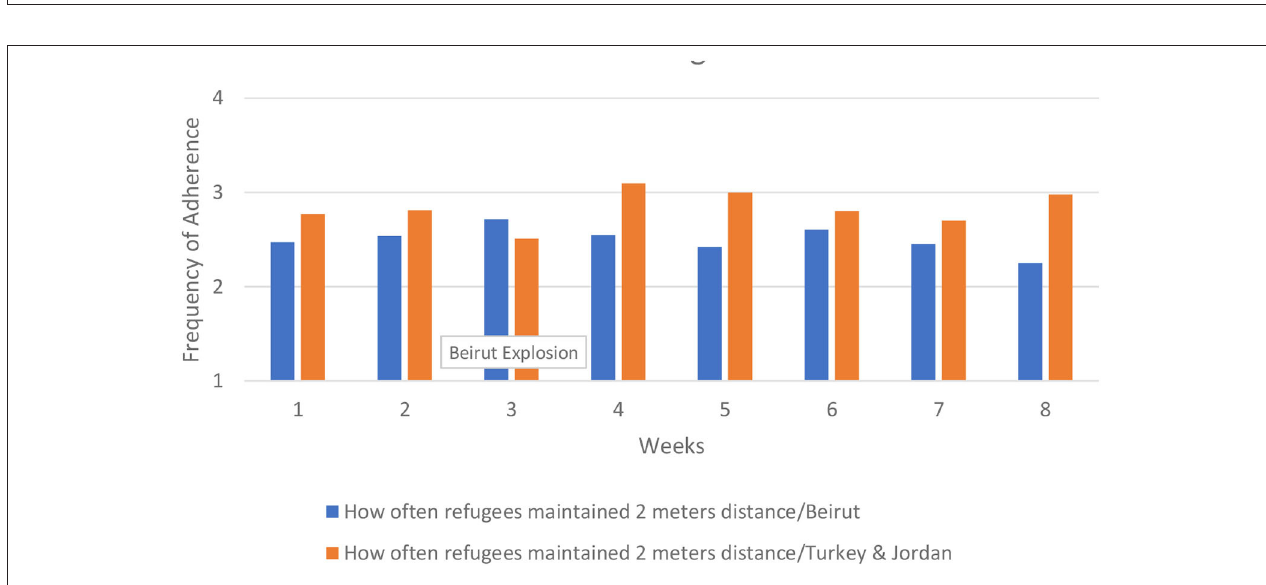
FIGURE 6 | How often refugees maintained social